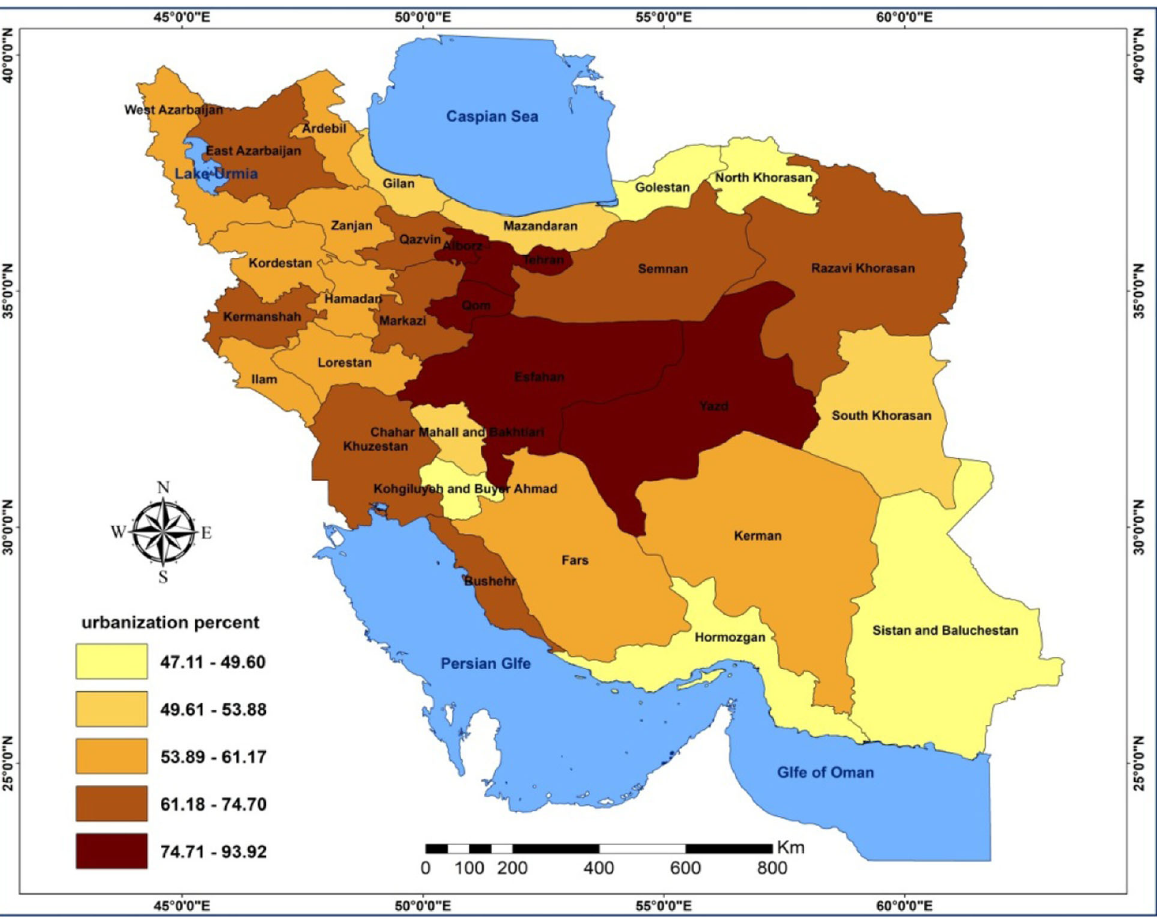
Fig. 5 Geographical distribution of urbanization in Iran (2006). Figure shows the largest urban population of Iran in 2006 in the central provinces of Yazd, Isfahan, and Tehran. The lowest share belongs to the southeastern part of Iran, including the provinces of Kerman, Sistan, and Baluchestan and South Khorasan (Sources: Research fi